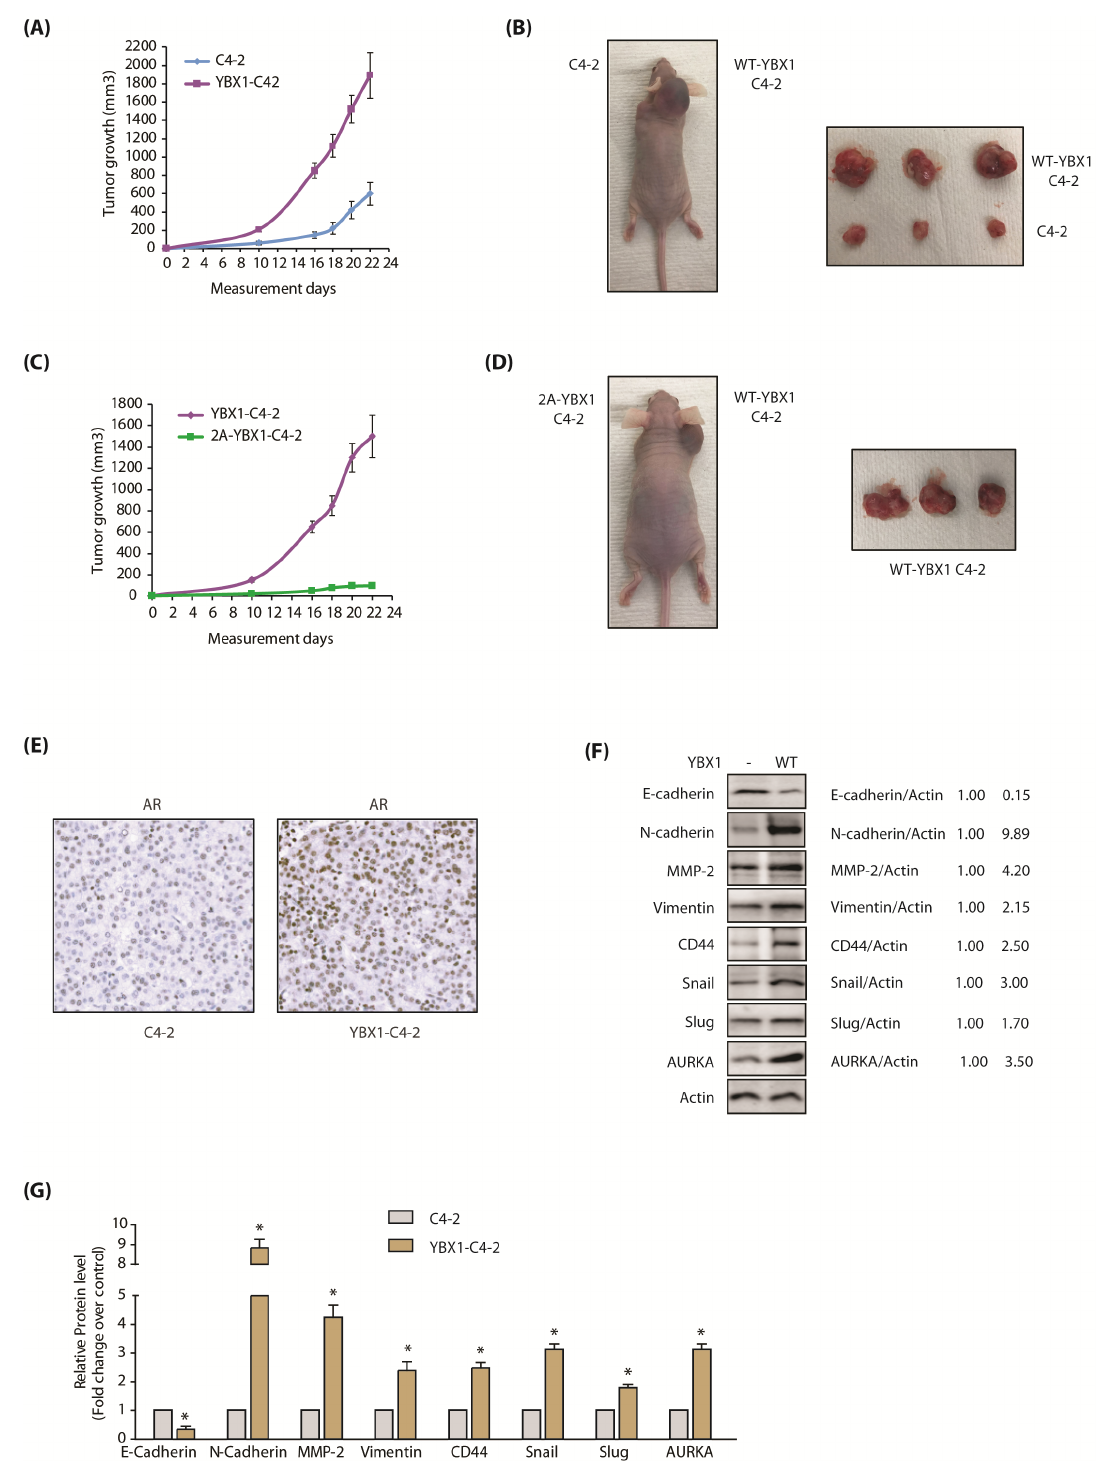
Figure 7. The AURKA-YBX1 loop promotes tumorigenesis in vivo. ( A ) YBX1 overexpression enhances tumorigenesis in vivo. Three male nude athymic mice were injected with C4-2 cells and YBX1-C4-2 cells on left and right shoulders, respectively. ( B ) Nude athymic mice were inoculated with YBX1-C4-2 cells and C4-2 cells on the right and left shoulders, respectively. The pictures were taken 22 days following injection. Representative images are shown. ( C ) 2A-YBX1 expression inhibits tumor growth in vivo. Three nude mice were injected with 2A-YBX1-C4-2 and YBX1-C4-2 cells on the left and right shoulders, respectively. ( D ) Athymic nude mouse were inoculated with YBX1-C4-2 cells and 2A- YBX1-C4-2 cells on right and left shoulders, respectively. The pictures were taken 22 days following